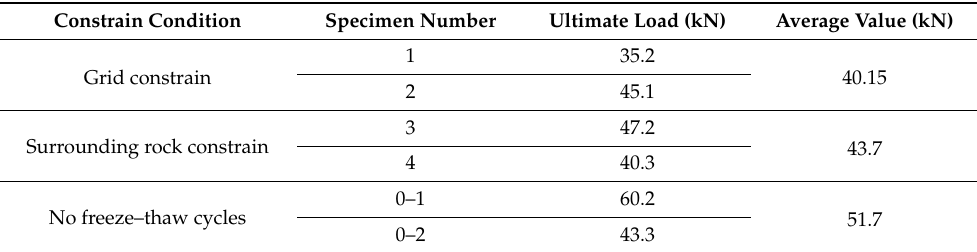
Table 2. Ultimate load value of test